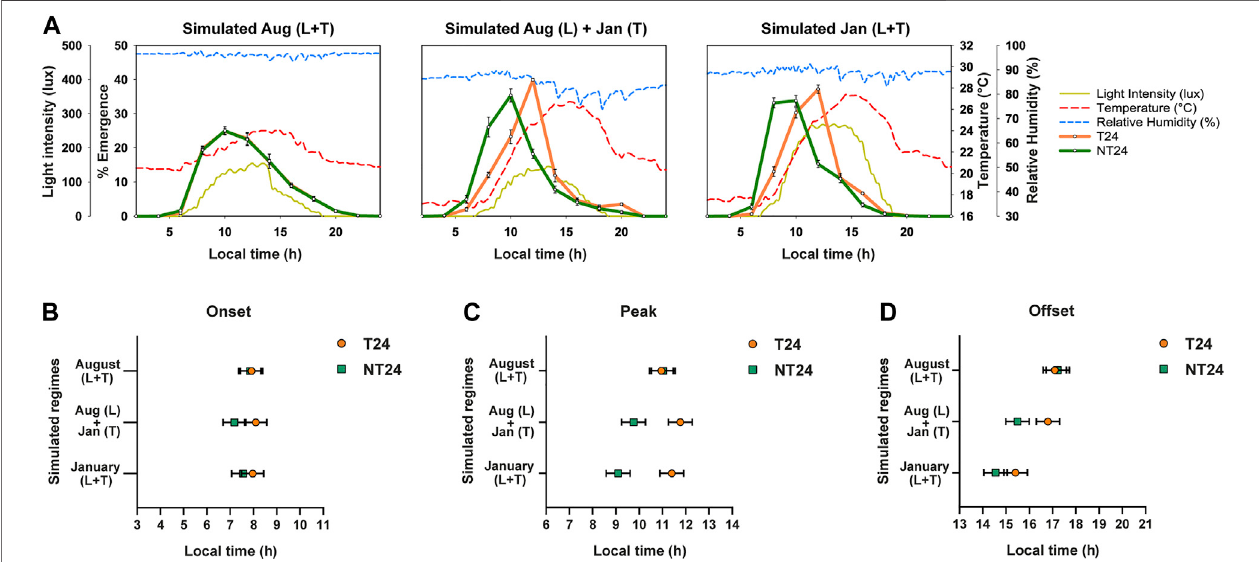
FIGURE 5 | Phasing of the eclosion rhythm under simulated natural light and temperature cycles. (A) Eclosion pro fi les for NT24 (green) and T24 (orange) populations, under three simulated semi-natural conditions in laboratory incubators with average pro fi les for environmental variables of light (yellow-solid curve), temperature (red-dashed curve) and humidity (blue-dashed curve). Header indicates similarity of simulated regime to that observed in our outdoor enclosure during speci fi c months (as Fig. 2). (B) Average phase of Onset: Three-way ANOVA, Selection ; p < 0.05, Error bars: 95% CI via Tukey ’ s HSD (not signi fi cant for Selection ). (C) Average phase of Peak: Three-way ANOVA, Selection , Regime , Selection × Regime ; p < 0.05, Error bars: 95% CI via Tukey ’ s HSD (signi fi cant for Selection × Regime ). (D) AveragephaseofOffset:Three-wayANOVA, Selection , Regime , Selection × Regime ; p < 0.05,Errorbars:95%CIviaTukey ’ sHSD(signi fi cantfor Selection × Regime